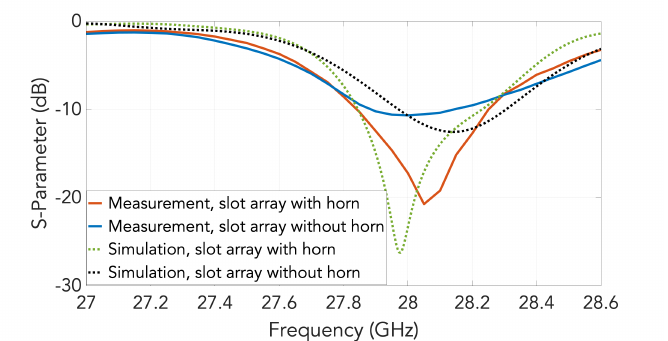
Figure 13. Measured and simulated S 11 of the 2D transverse waveguide slot array with and without